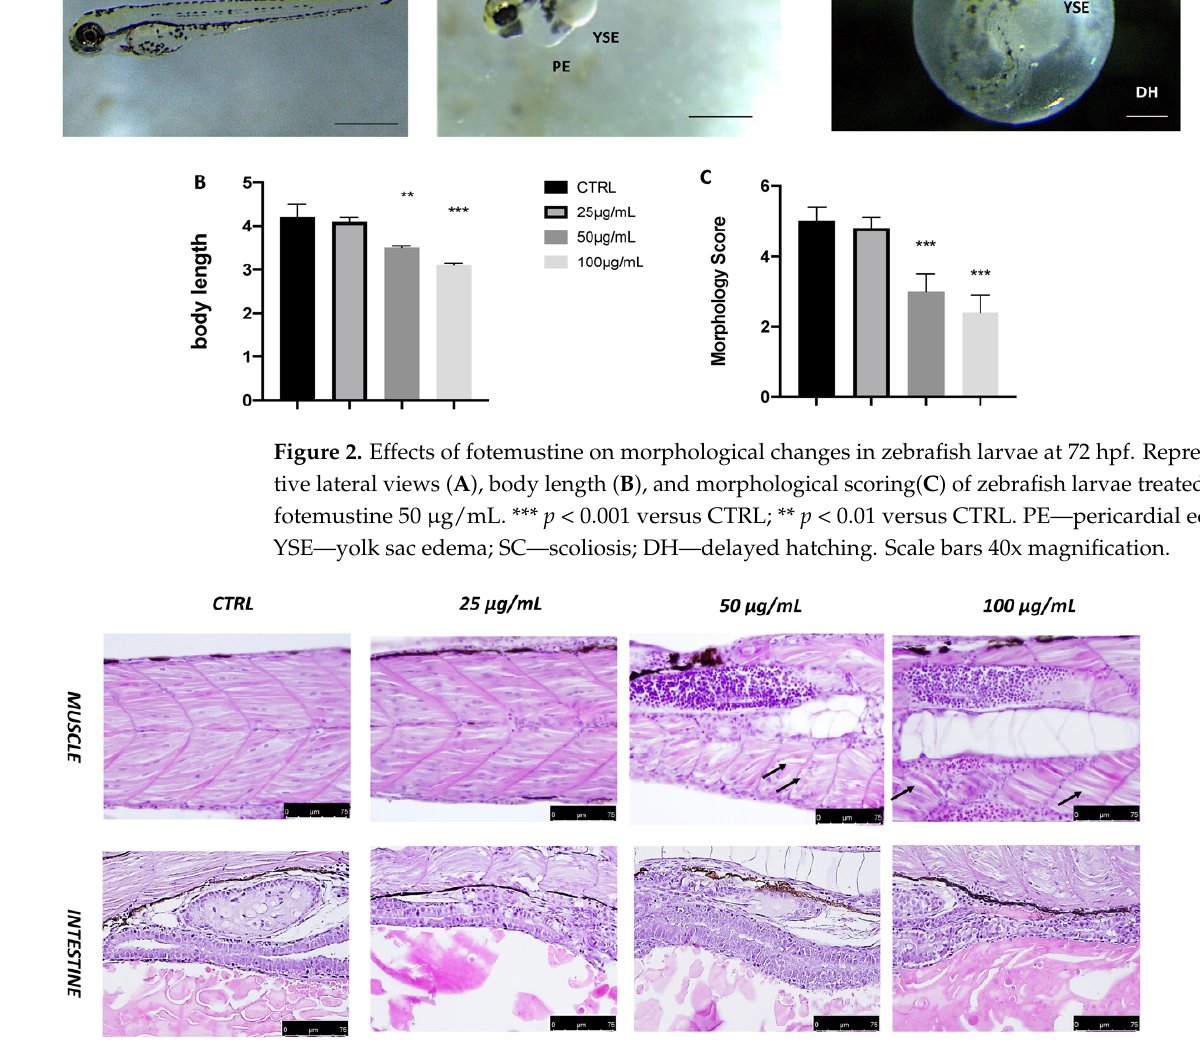
Figure 2. Effects of fotemustine on morphological changes in zebrafish larvae at 72 hpf. Representative lateral views ( A ), body length ( B ), and morphological scoring( C ) of zebrafish larvae treated with fotemustine 50 µg/mL. *** p < 0.001 versus CTRL; ** p < 0.01 versus CTRL. PE— pericardial edema; YSE—yolk sac edema; SC—scoliosis; DH—delayed hatching. Scale bars 40x